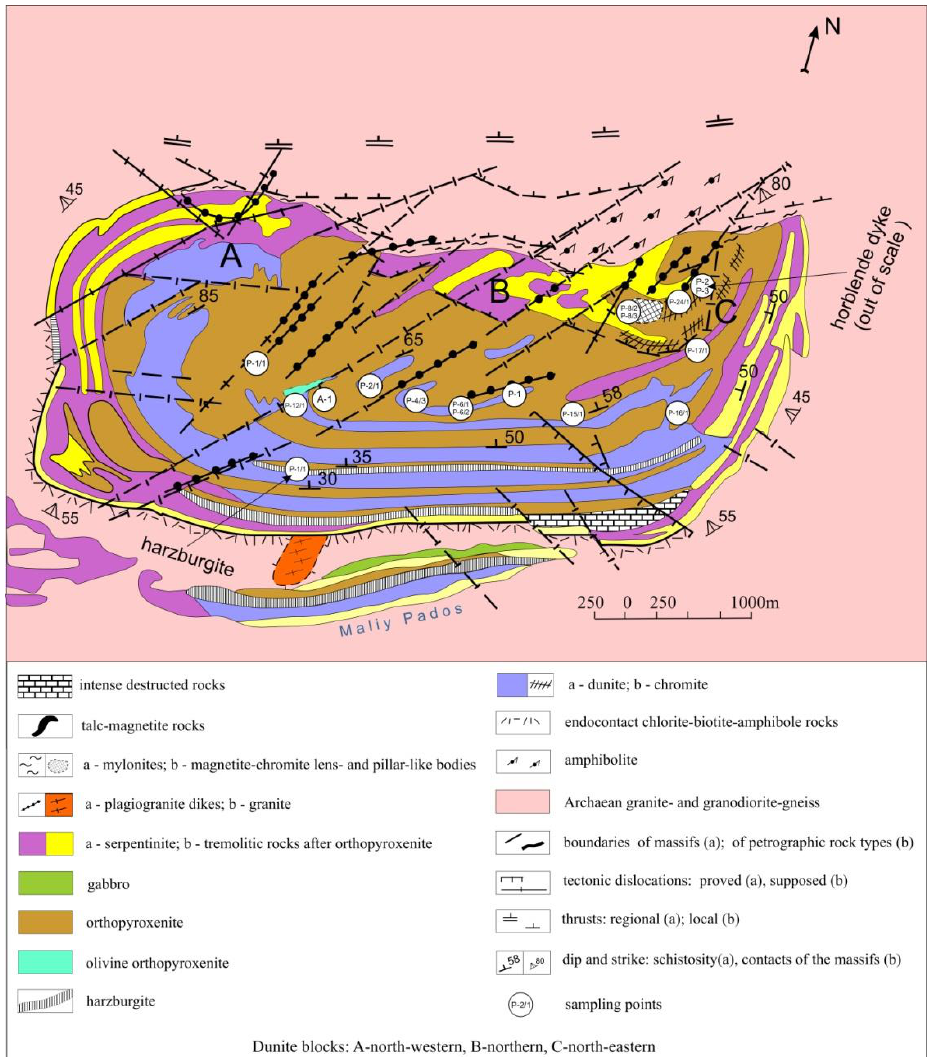
Figure 3. Geological map of the Pados-Tundra and Maliy Pados complexes (kindly provided by V.F. Smolkin, unpublished data; amended).